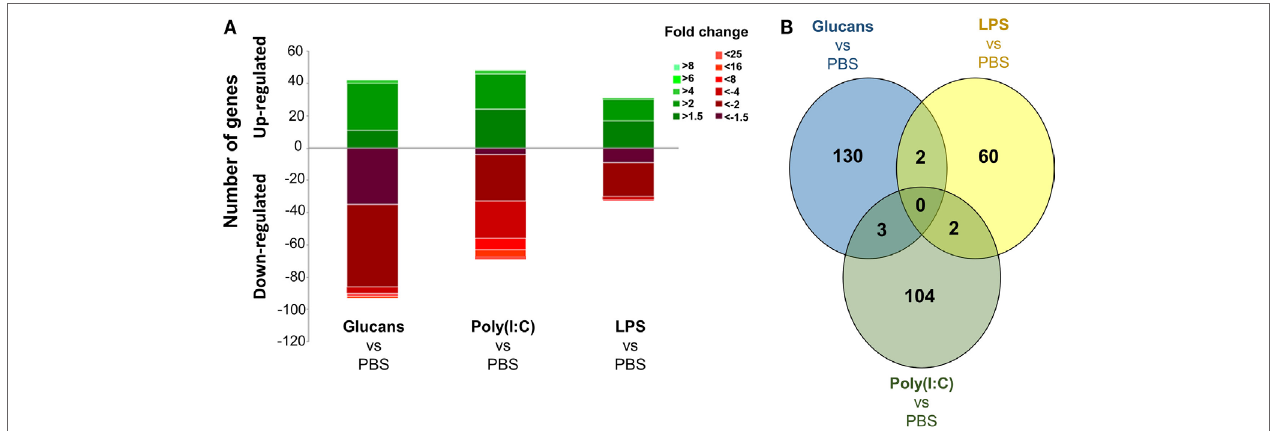
FigUre 1 | Analysis of gene modulation in the zebrafish kidney at 35 days poststimulation with the three pathogen-associated molecular patterns (PAMPs) compared to individuals inoculated with phosphate-buffered saline. (a) Stacked column chart reflecting the distribution of the DEGs. Statistically significant differentially expressed genes are subdivided according to intensity (fold change) and sense (up- and downregulation). (B) Venn diagram showing the number of shared and exclusive modulated genes in the three treated groups. Even after 35 days, the response was found to be very exclusive depending on the